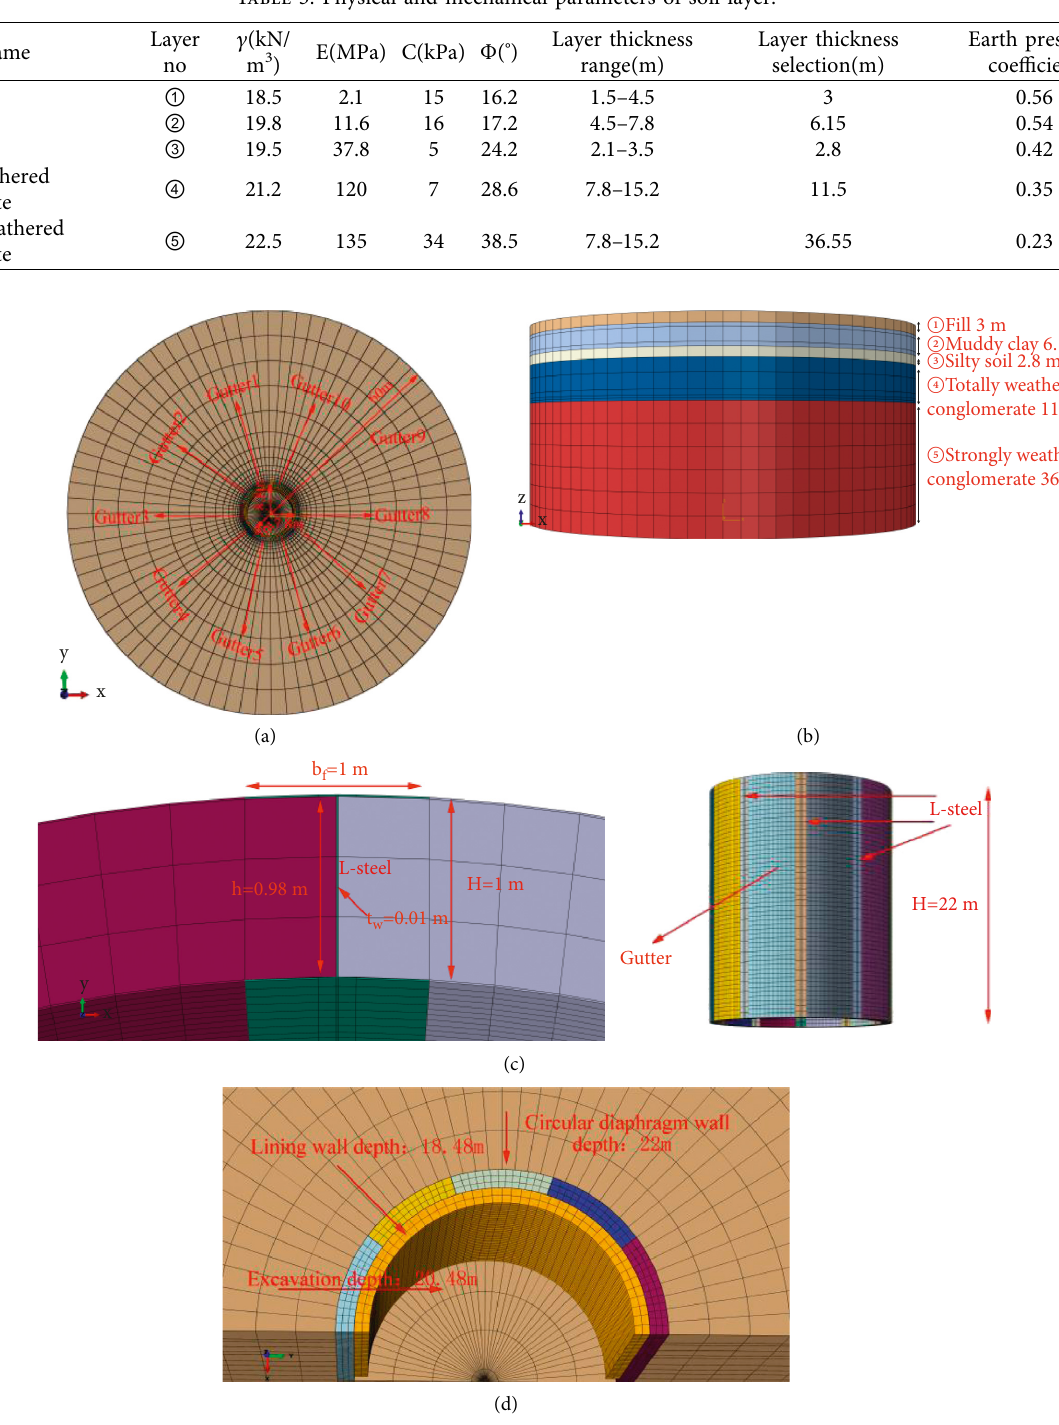
Figure 3: FEM mesh. (a) Vertical view. (b) Front view. (c) Detail finite element mesh of circular diaphragm wall. (d) Detail finite element mesh of the circular